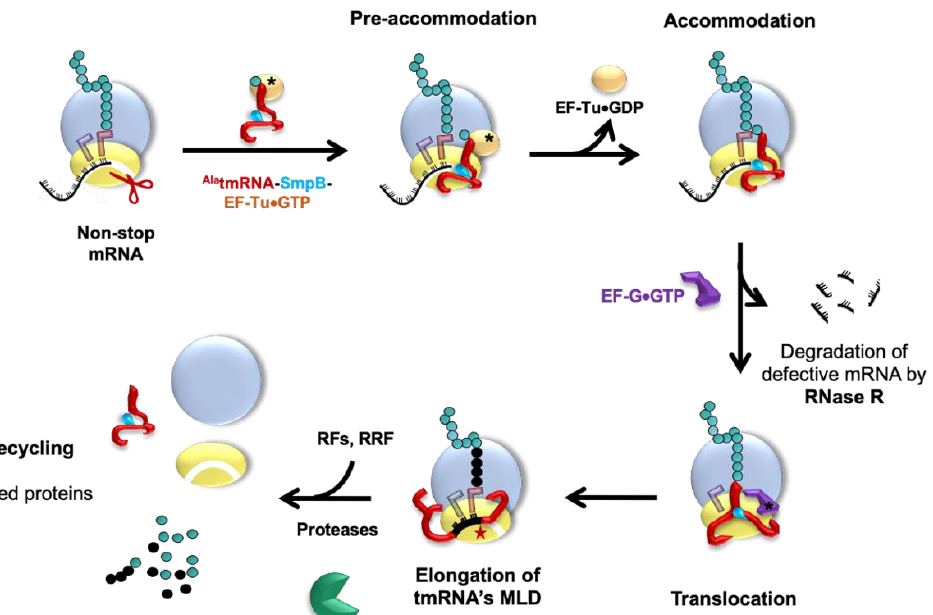
Figure 3. The complete trans -translation quality control cycle. Pre-accommodation state: